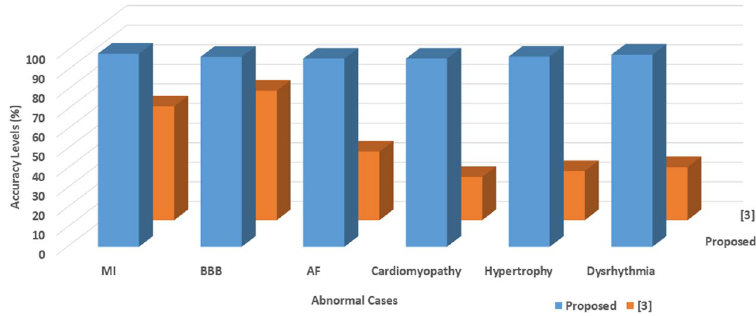
Figure 5. Comparison of accuracy by the proposed methodology and existing work.